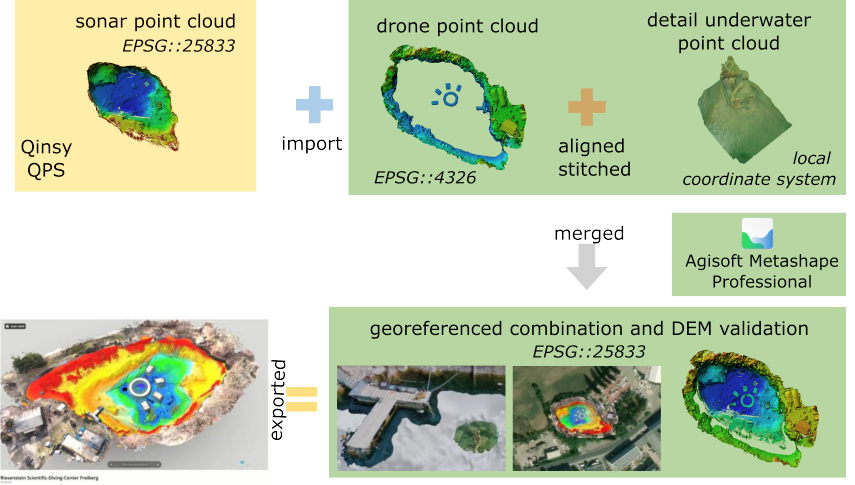
Figure 12. Combination of the sonar data processed with Qinsy [39], the drone recordings and underwater models aligned and stitched by Metashape for a holistic georeference